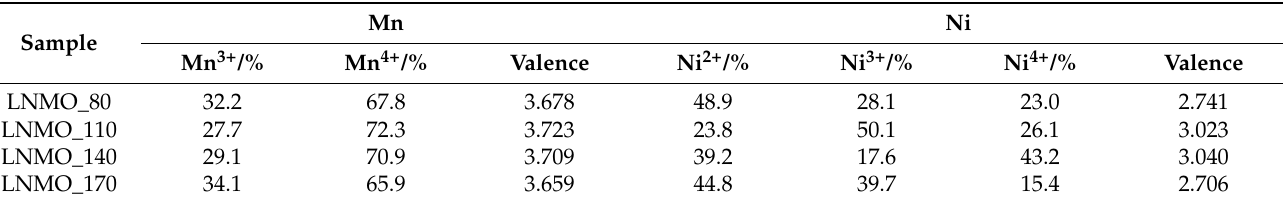
Figure 5. XPS spectra of LNMO_110 sample: ( a ) full survey, ( b – d ) high-resolution spectra of O 1s, Mn 2p and Ni 2p 3/2 . Table 1. XPS and calculated results of Mn and Ni.